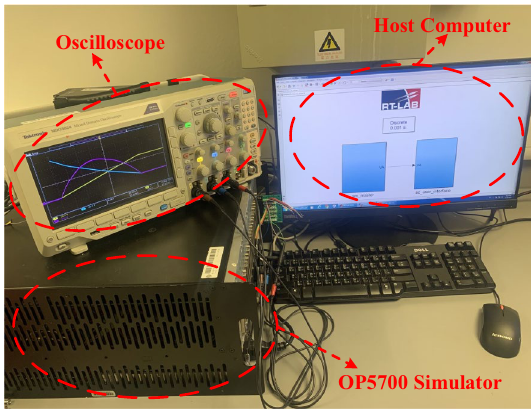
Fig. 15 Hardware-in-the-loop experiment using RTLAB platform